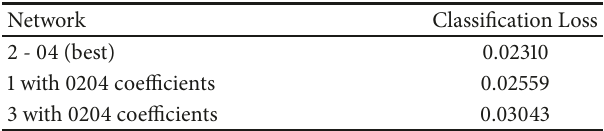
Table 5: CL for Networks 1 and 3 using the parameters of best Network 2-04.